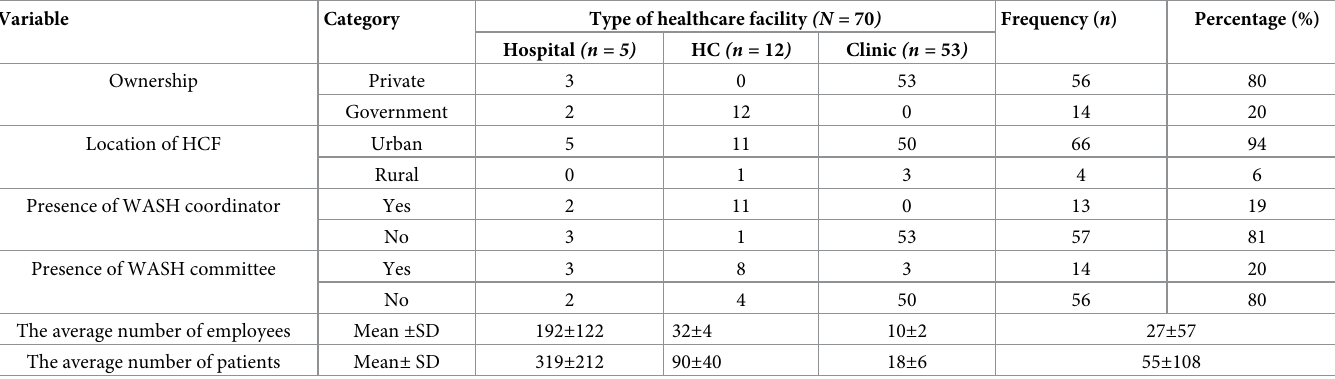
Table 1. Background information of the healthcare facilities in Northeastern Ethiopia from July to August 2020.